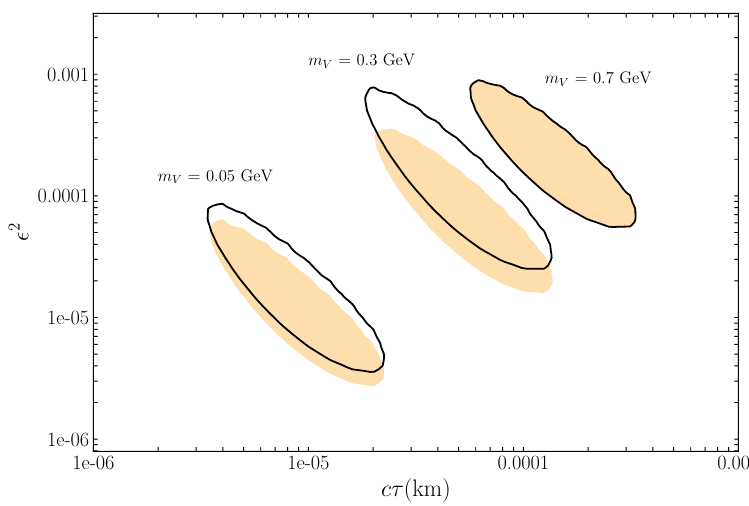
Figure 19 . 1 (cid:27) best (cid:12)t regions on dark photons decays in IceCube assuming uncorrelated (cid:15) 2 vs c(cid:28) . The black lines correspond to considering only the signal from (cid:25) 0 decay for m V = 0 : 05 GeV, only (cid:17) decay for m V = 0 : 3 GeV and only bremsstrahlung for the heavier mass. straints [62, 70, 71] in this dark photon mass range and, at the same time, such as small c(cid:28) for a HNL at m = 0 : 35 GeV is at least one order of magnitude too small, assuming N N that the mixing is below the present constraints from direct searches of HNL